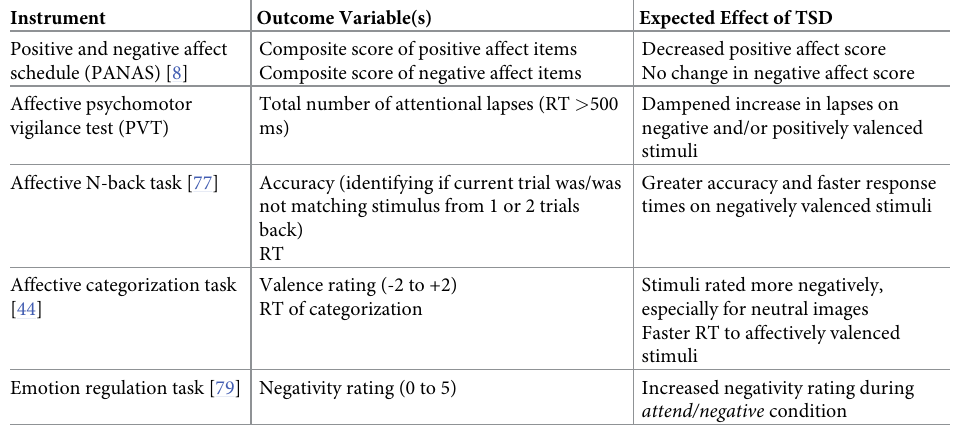
Table 1. List of instruments used in the current study, their corresponding outcome measures, and the expected effect of TSD.